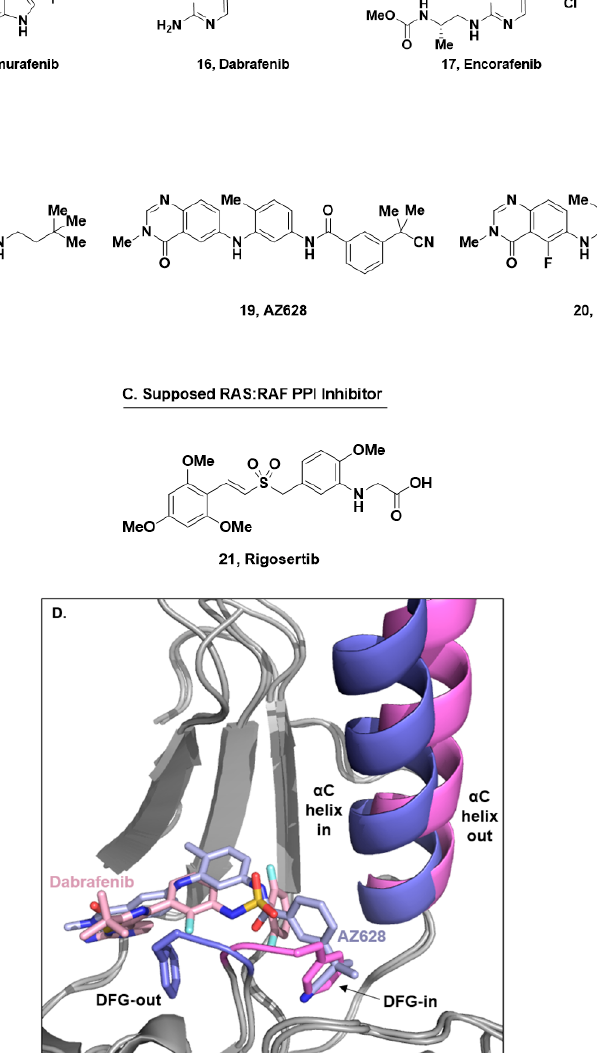
Figure 7. ( A ) Compound structures of commercial B-RAF V600E inhibitors vemurafenib, dabrafenib, and encorafenib ( 15 – 17 ). ( B ) Selected pan-RAF inhibitors LYS3009120, AZ628, and GNE-0749 ( 18 – 20 ). ( C ) Chemical structure of rigosertib ( 21 ), the supposed RAS:RAF PPI inhibitor. ( D ) Comparison of X-ray crystal structures of dabrafenib ( 16 , in pink) and AZ628 ( 19 , in blue) bound to BRAF V600E showing ligand-induced conformational changes of the DFG-motif and α C-helix. The DFG-out/ α C-helix-in conformation prevents dimerization under activated RAS conditions.